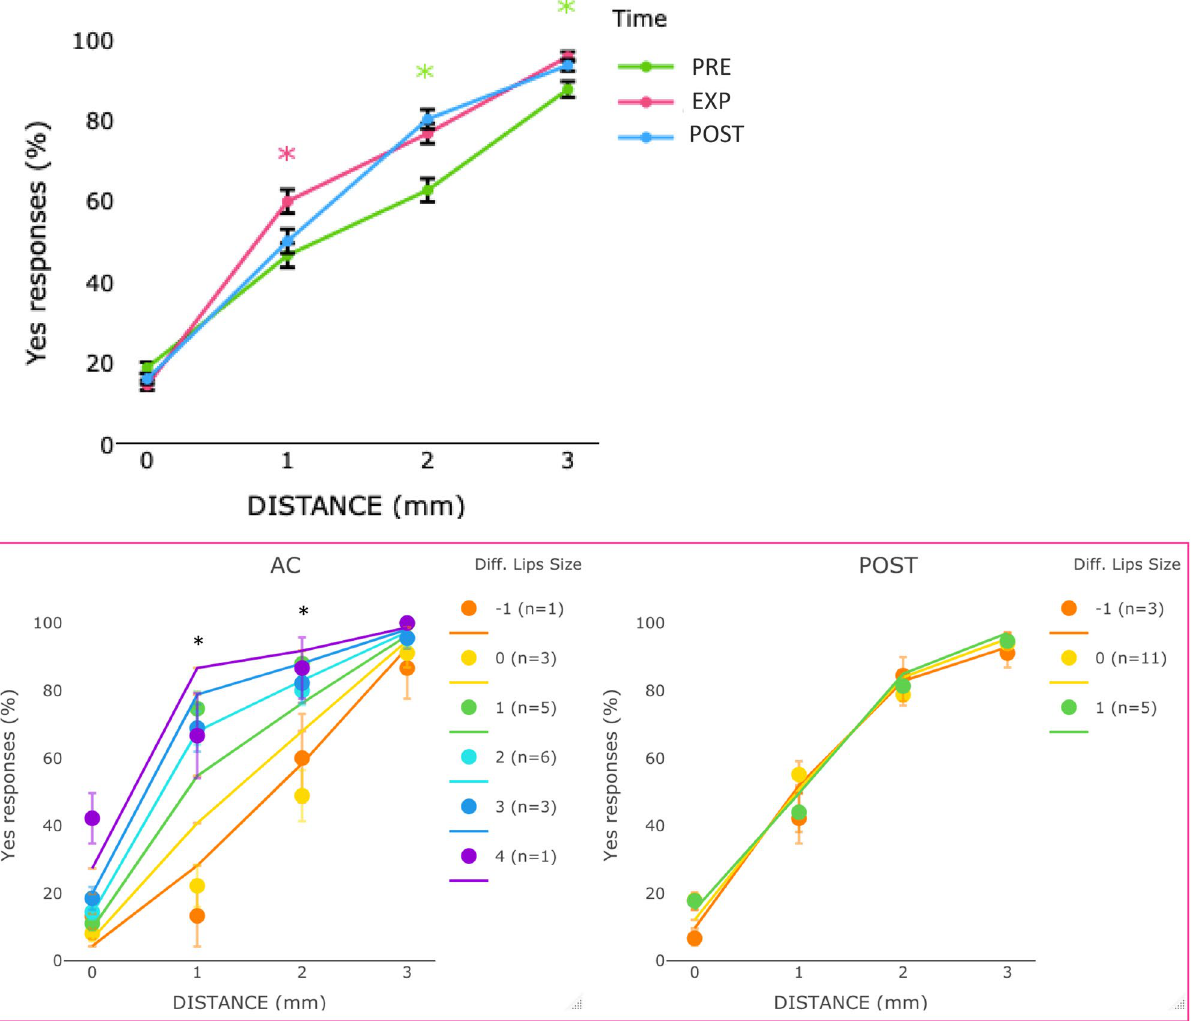
Figure 2. Top panel, mean (markers) and SE of the means (error bars) of yes responses in 2PD in PRE, EXPERIMENTAL and POST conditions for each distance (0, 1, 2, 3 mm) in Experiment 1. The star indicates significant ( p < 0.05) effect. The color of the star indicates which condition differed from the others. Bottom panel, mean and SE of the means (error bars) of yes responses in 2PD in EXPERIMENTAL (left panel) and POST (right panel) conditions as a function of distance (0, 1, 2, 3 mm) between 2 stimulation sites and the change in the perceived lip size in Experiment 1. The legend describes the amount of perceived change in the lip size and the number of individuals who perceived that change. Negative numbers indicate a perceived decrease and positive numbers indicate an increase in the perceived lip size compared to PRE. For example, ‘− 1 (n = 1)’ indicates that one participant perceived a decrease in lip size of 1 unit, while ‘1 (n = 5)’ indicates that five participants experienced an increase in lip size of 1 unit. In the bottom row plots, colored lines represent the estimated effects in the LMM analyses and the markers the performance of individuals in the EXPERIMENT or POST based on change in the perceived lip size in that condition with respect to the